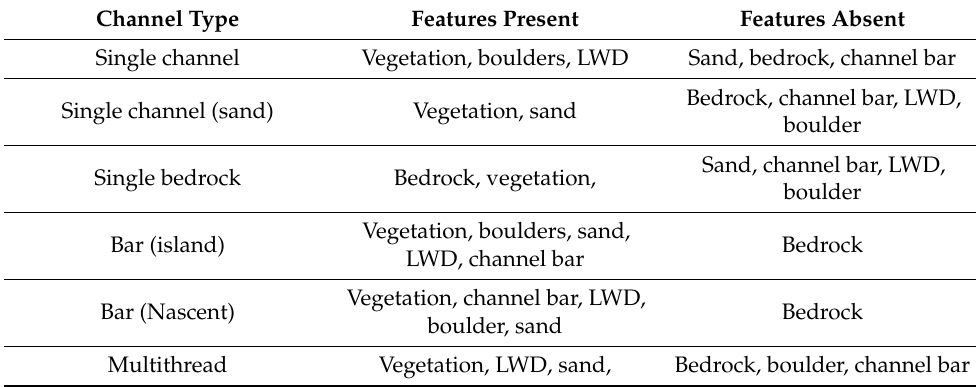
Table 1. Geomorphic features associated with defined channel